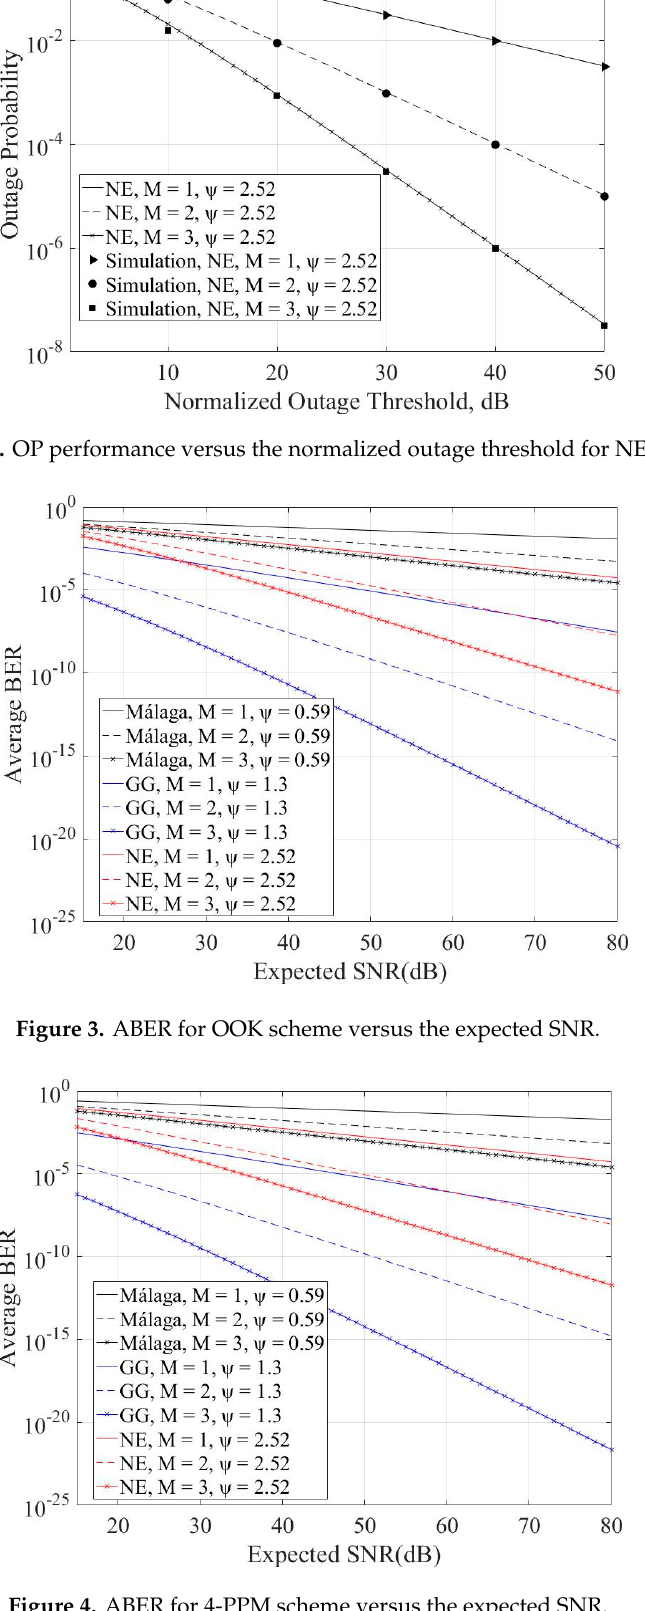
Figure 4. ABER for 4-PPM scheme versus the expected SNR.